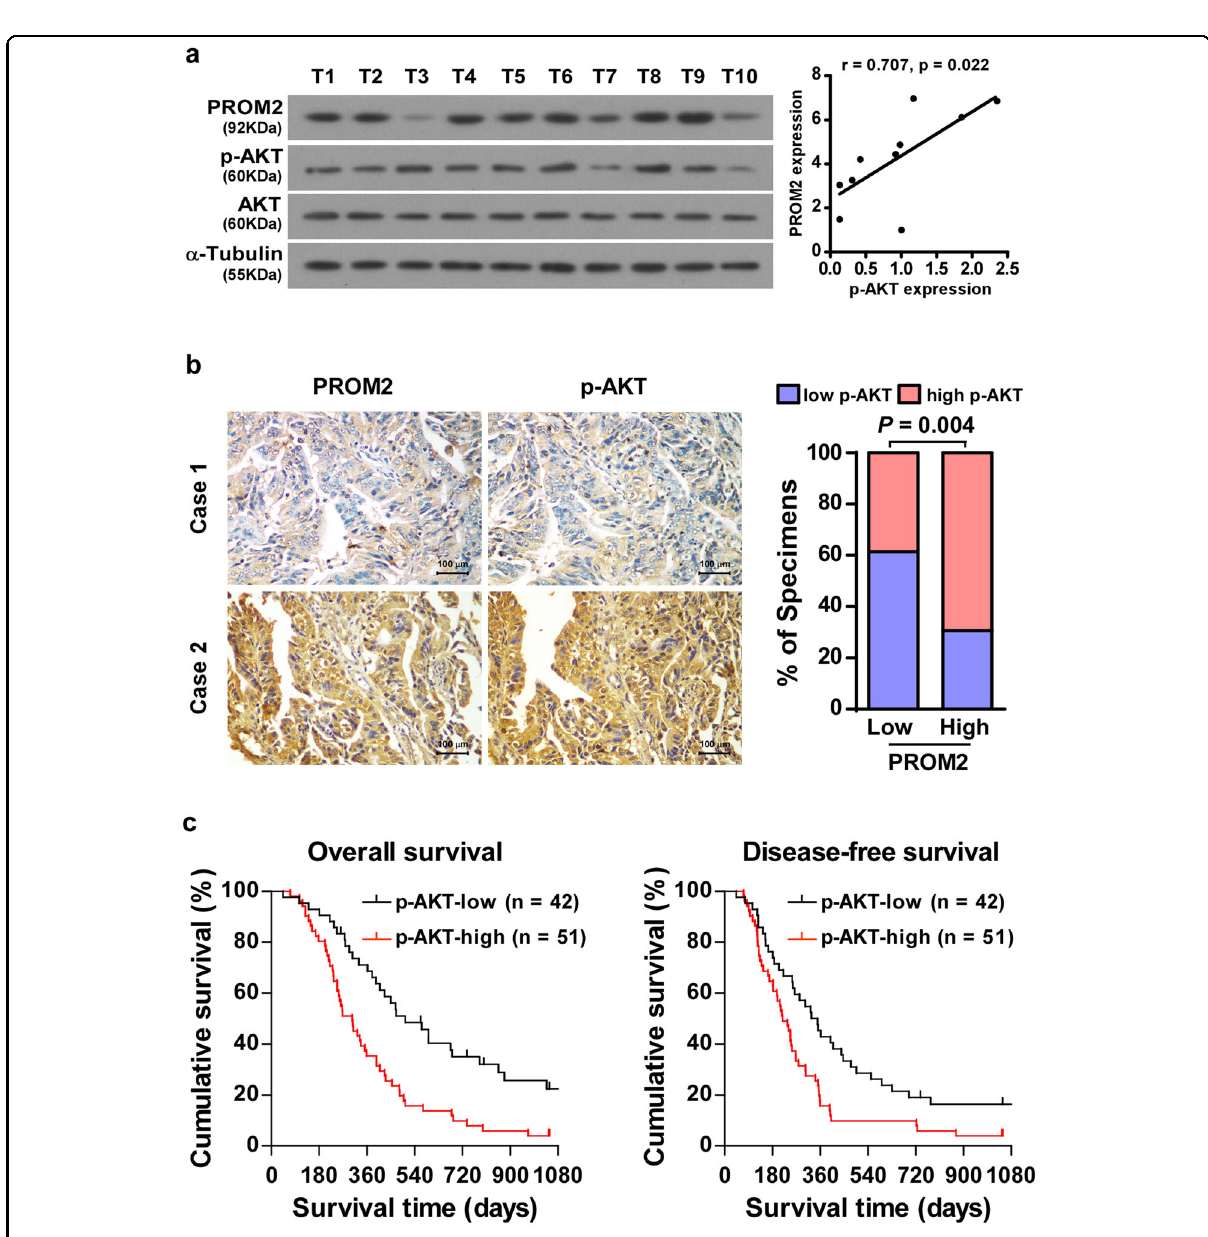
Fig. 7 Clinical relevance of PROM2-induced activation of Akt signaling in pancreatic cancer. a PROM2 is positively correlated with p-Akt in 10 freshly collected pancreatic cancer tissues ( r = 0.707, P = 0.022). b Immunohistochemistry assays revealing PROM2 is positively correlated with p-Akt in 93 paraf fi n-embedded pancreatic cancer samples ( P = 0.004). c P-Akt expression predicted poor overall (left) and disease-free (right) survival in pancreatic cancer samples ( P < 0.001, P <